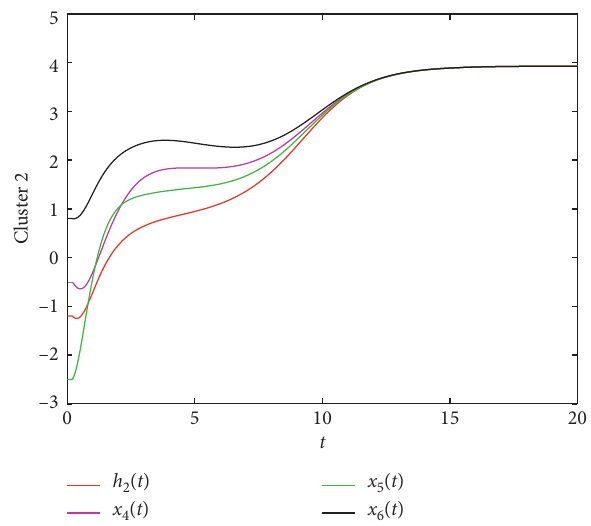
Figure 8: The trajectories of state changes in cluster